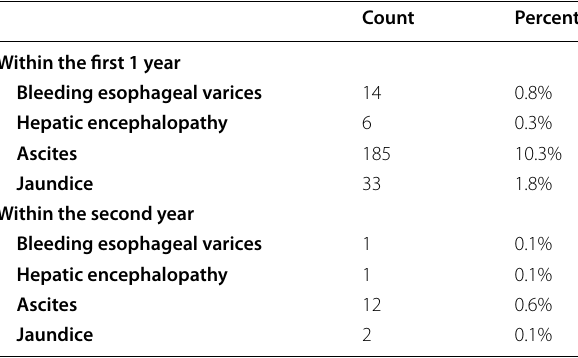
Table 2 Timing and description of hepatic decompensation